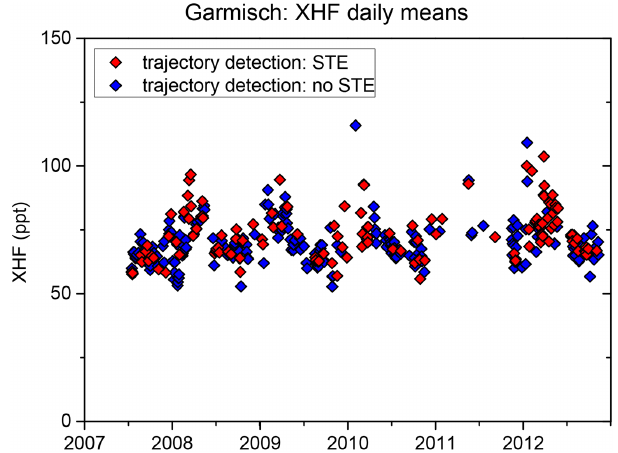
Figure D2. XHF daily mean time series for Garmisch obtained from NIR measurements (TCCON). The detection of measurement days affected by STE is described in Sect.